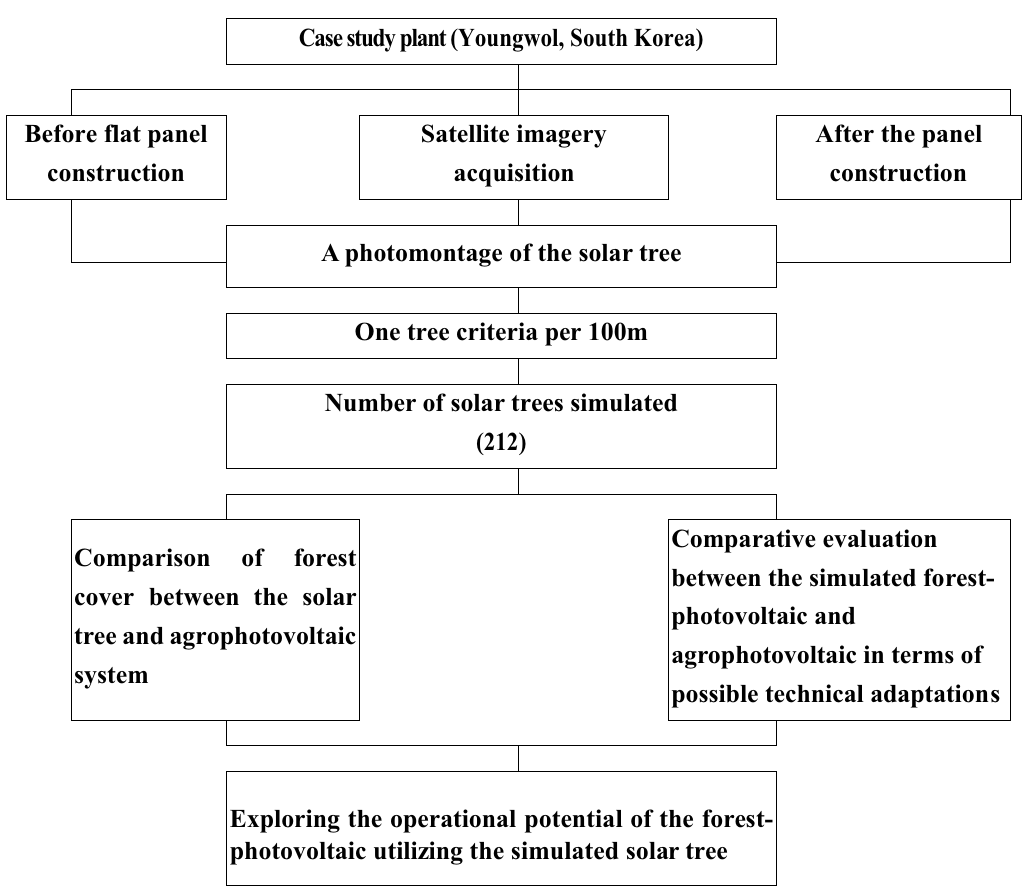
Figure 1. The procedures exploring the operational potential of the